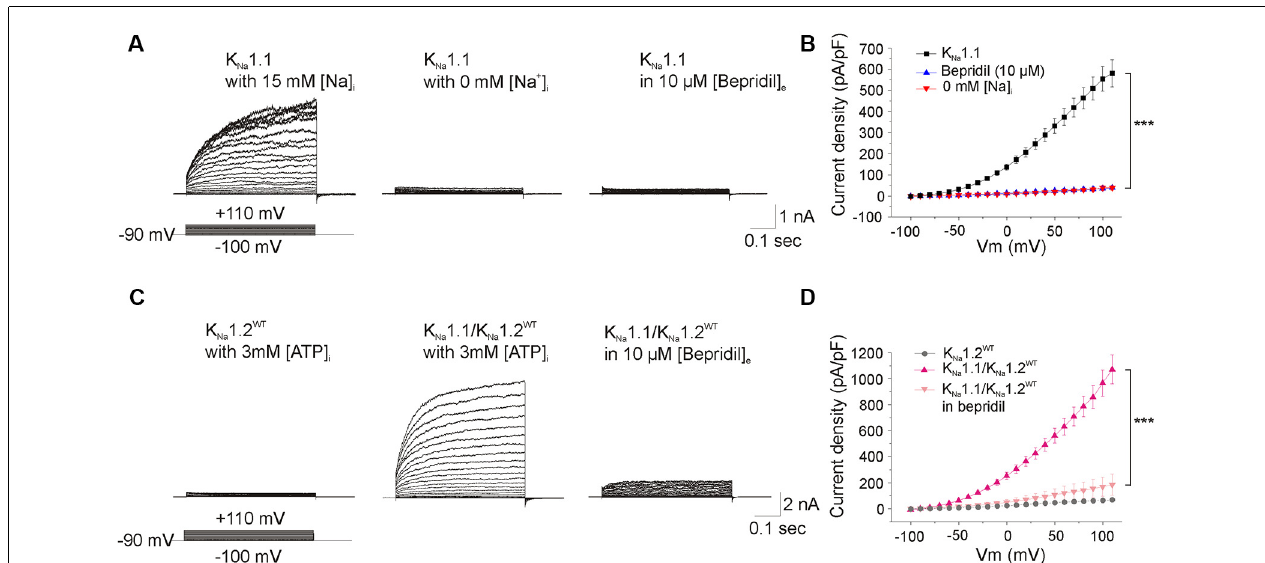
FIGURE 4 | Functional analysis of K Na 1.1 and heteromeric K Na 1.1/K Na 1.2 channels. (A) Current traces evoked by voltage steps in cells expressing K Na 1.1 subunit and recorded with pipette solution containing either 15 mM Na + (left traces), or no Na + (middle traces), or 15 mM Na + and an extracellular medium containing 10 µ M bepridil (right traces). (B) Current densities measured in the three recording conditions as in (A) . (C) Current traces recorded with pipette solution containing 3 mM ATP/0.3 mM GTP in cells expressing the K Na 1.2 WT subunit (left traces), both K Na 1.1 and K Na 1.2 WT subunits (middle traces) and both K Na 1.1 and K Na 1.2 WT subunits in the presence of 10 µ M bepridil in the extracellular medium (right traces). (D) Current densities measured in the three conditions as depicted in (C) . Two-way ANOVA with Tukey’s correction for multiple comparisons. ∗∗∗ p <